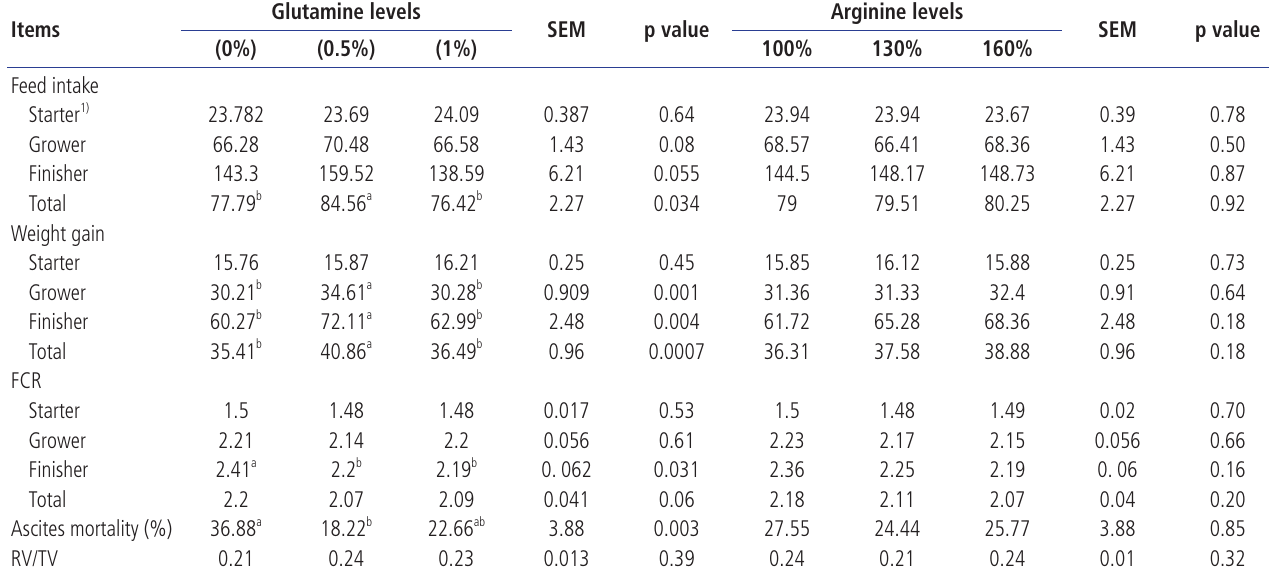
SEM, standard error of the mean; FCR, feed conversion ratio; RV, right ventricle; TV, total ventricular. 1) Starter (1-10 d), grower (11-24 d), finisher (25-42 d), total (1-42 d). a,b Means in each row with no common superscript differ significantly (p<0.05).